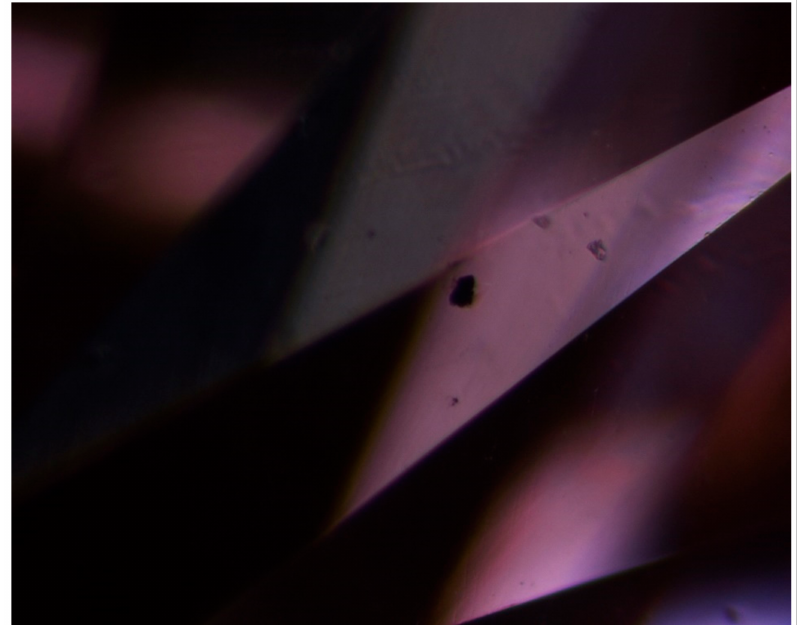
Figure 2. Black pinpoint and irregular inclusions (probably non-diamond carbon) are present in the most of the CVD synthetic diamonds, as shown here in the ZX03 sample grown by Huzhou SinoC Semiconductor Science and Technology Co., Ltd. In China. Photomicrograph by Z. Song; magnified 50 ×